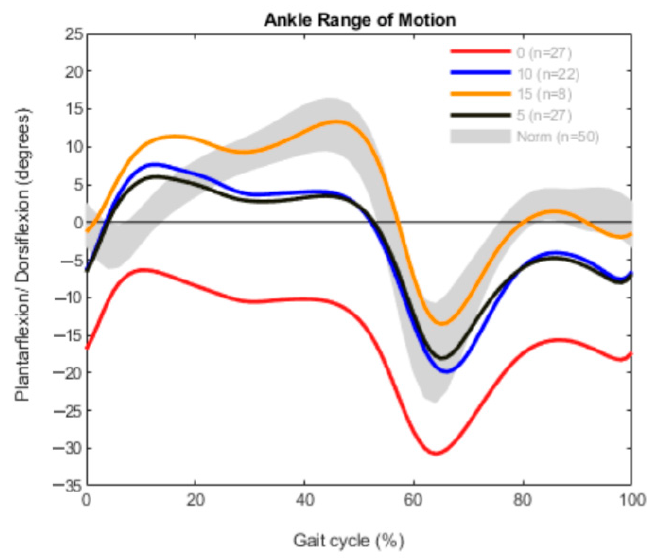
Figure 1. Range of motion measurement in the bilateral group ( n = 84).